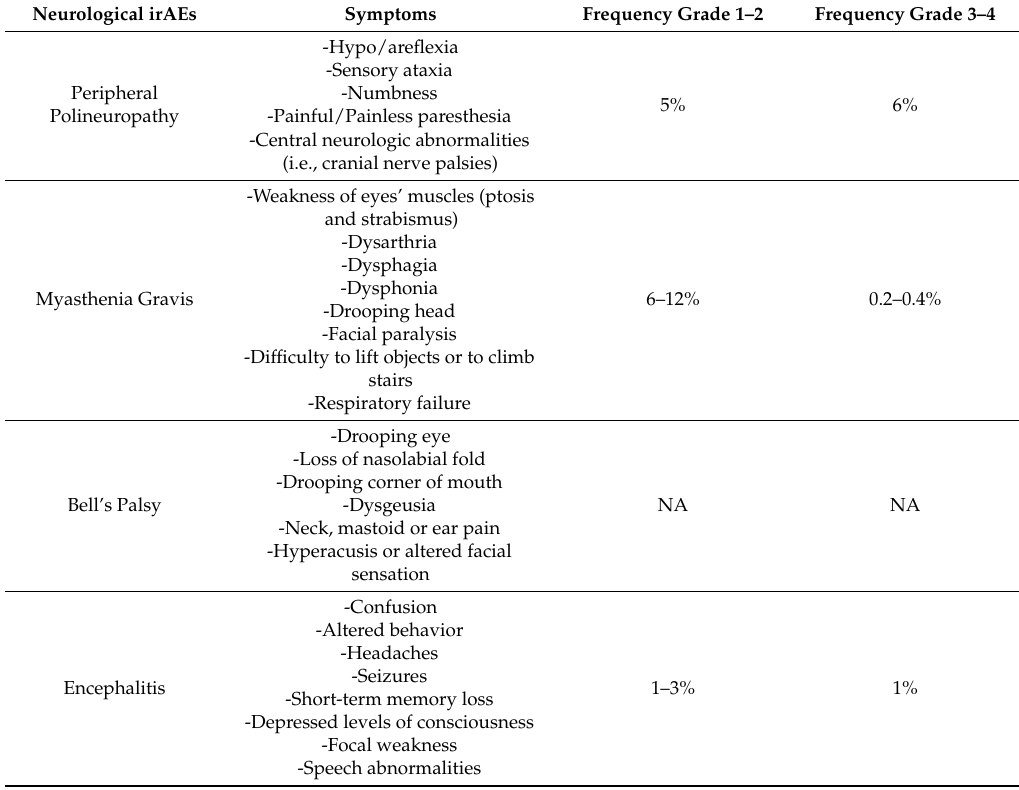
Table 2. Symptoms, signs, and frequency of the principal neurological